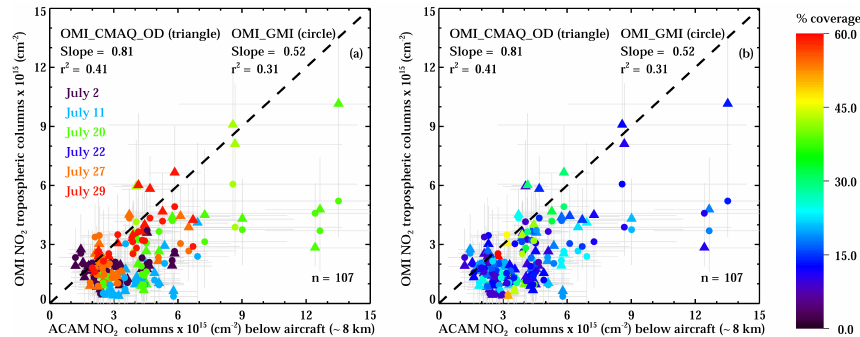
Figure 8. Tropospheric column NO 2 OMI_GMI and OMI_CMAQ_OD vs. co-located spatially and temporally matched ACAM NO 2 column measurements within ± 1h of a valid satellite overpass during July 2011. (a) Color-coded based on date. (b) Color-coded based on percent coverage. Error bars on both plots represent ± 1 SD away from the mean.